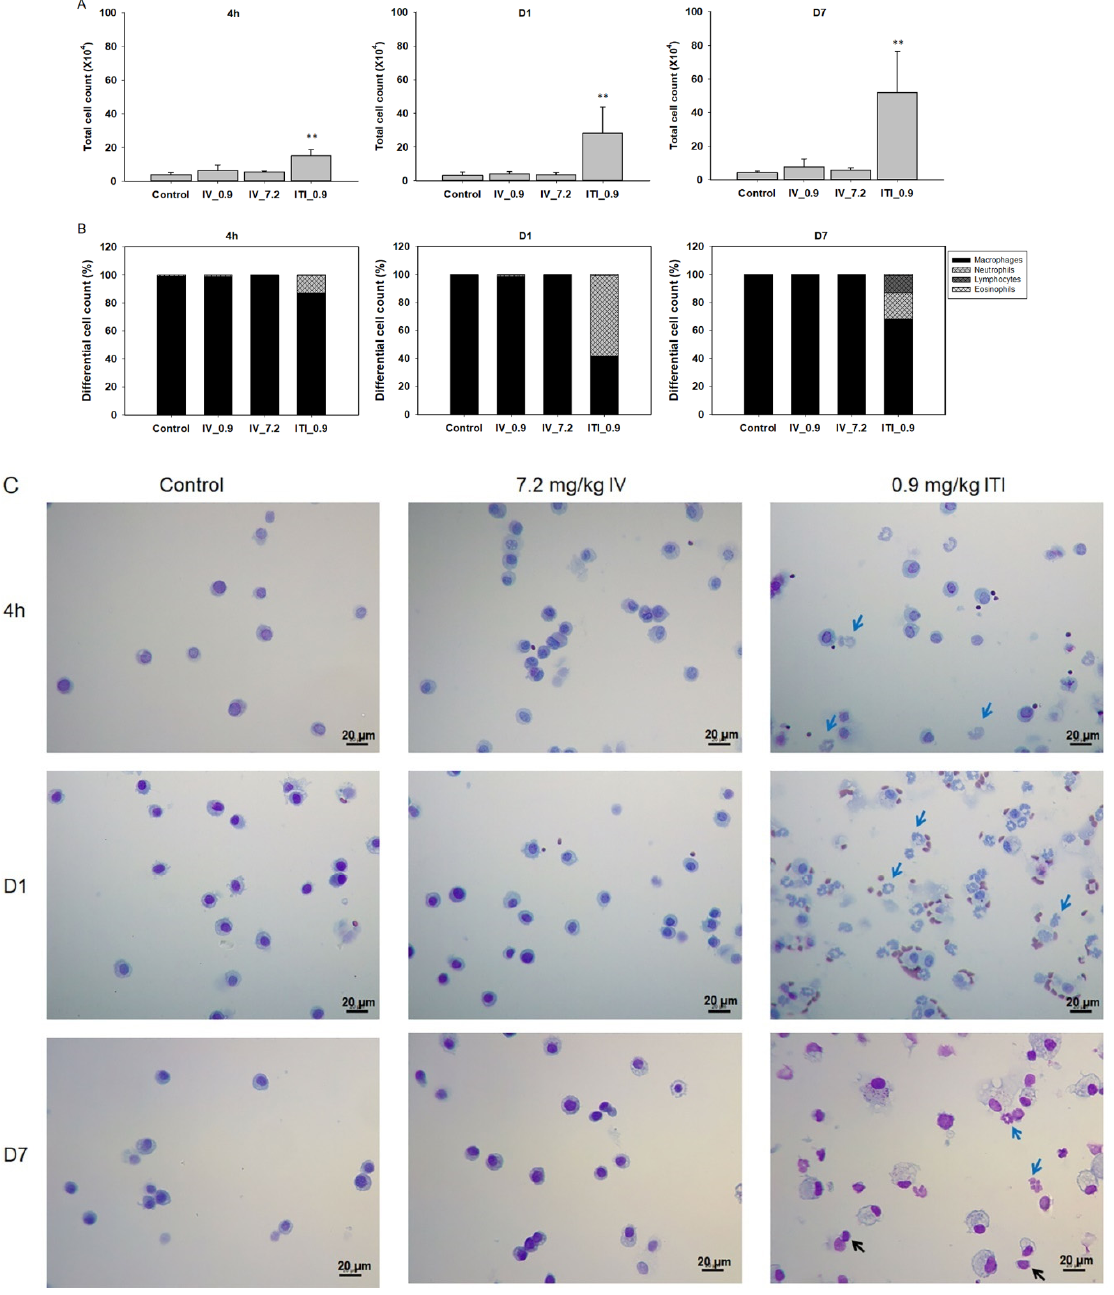
Figure 3. Cellular changes in bronchoalveolar lavage (BAL) of PHMG-P-treated mice: Total cell number in the BAL ( A ), differential cell number in the BAL ( B ), and representative photographs of Diff-Quik-stained BAL cells ( C ). Bars represent the mean ± standard deviation ( n = 5 per group). Values are significantly different from the control group: ** p < 0.01. Blue arrows indicate neutrophils and black arrows indicate lymphocytes. Scale bar: 20 µm.